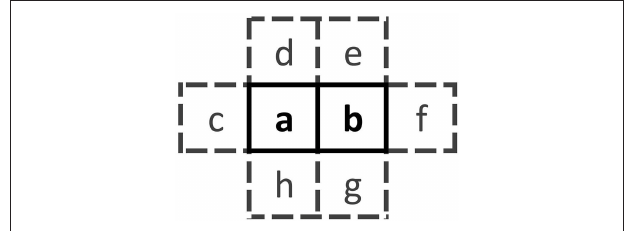
FIGURE 4 | Template for the neighborhood χ consisting of the pair ab and its six nearest neighbors c through h . Each letter can take on the value 0 or